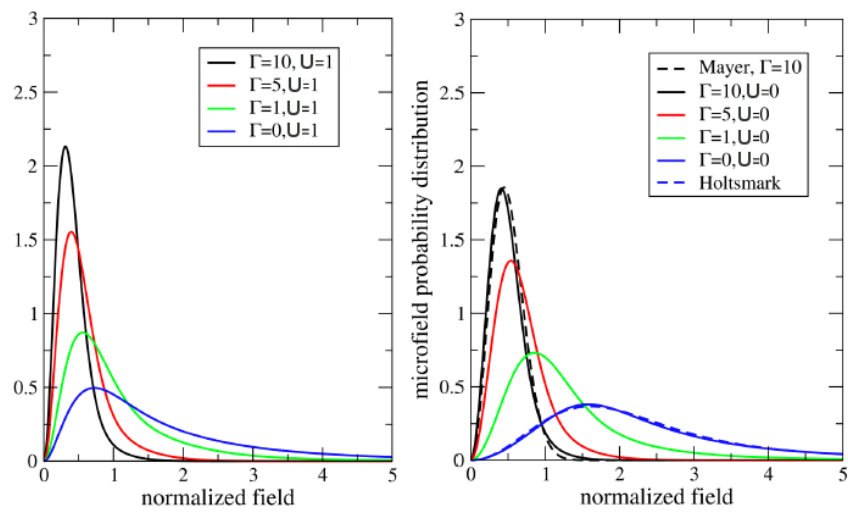
Figure 3. Microfield distributions at a charged emitter are calculated as a function of the reduced field for different values of the ion coupling parameter Γ and screening factor U , using the fit functions of Ref